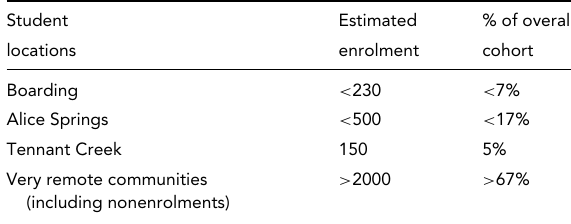
Location and Distribution of Aboriginal High School Students Within the CLC Region Student Estimated % of overall locations enrolment cohort Boarding < 230 <